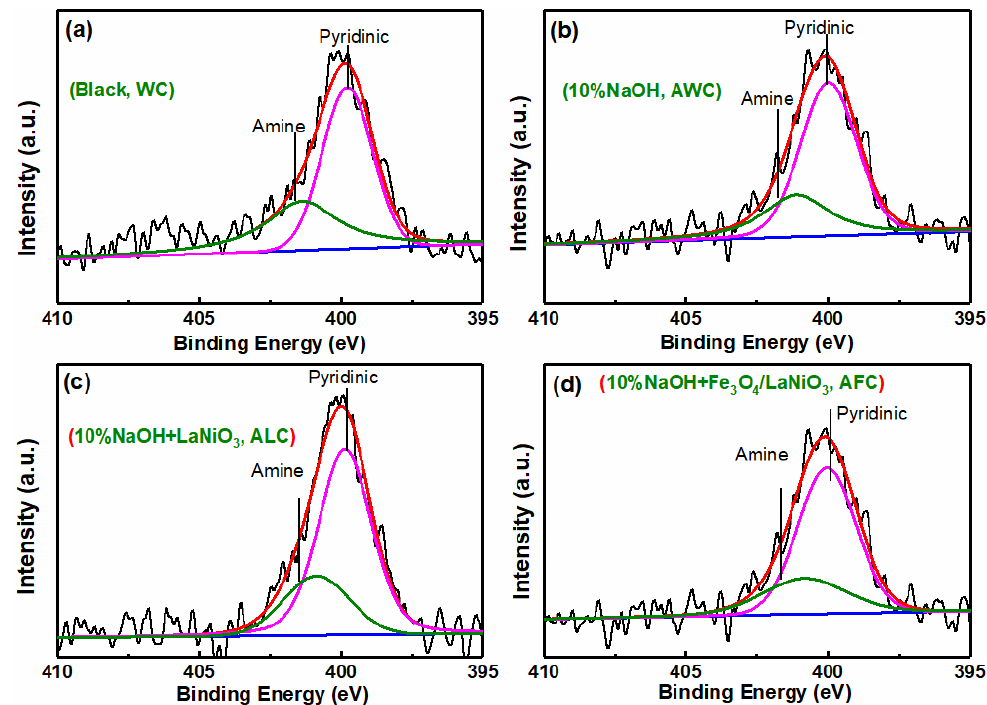
to fitted curves in Figures 7 and 8.